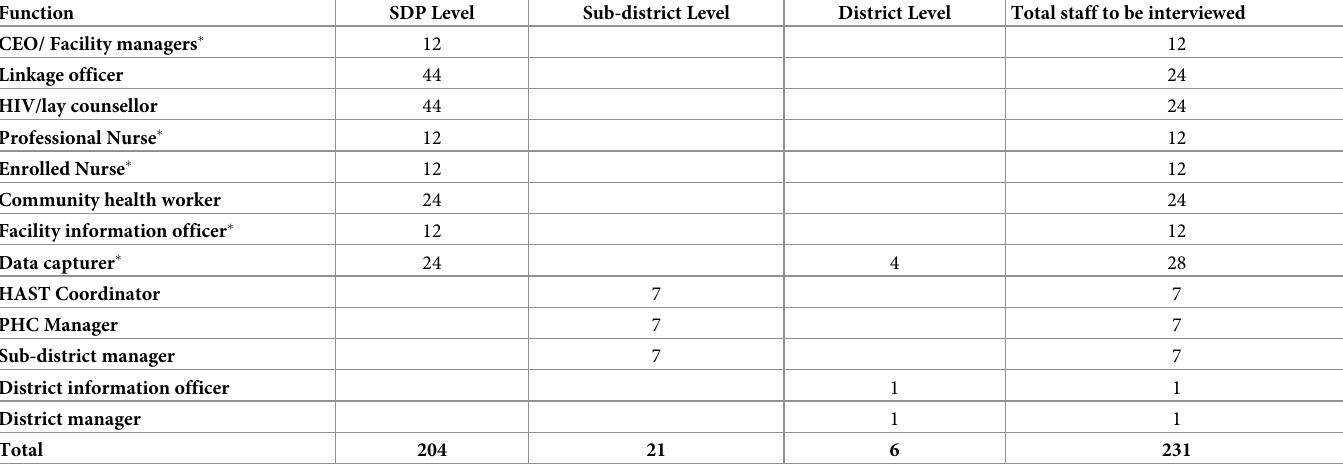
Table 3. Sampling strategy for selecting healthcare providers across the SDPs for the SHeS’Cap-Linkage study in uMgungundlovu district, KwaZulu-Natal, South Africa, 2021–2023. Function